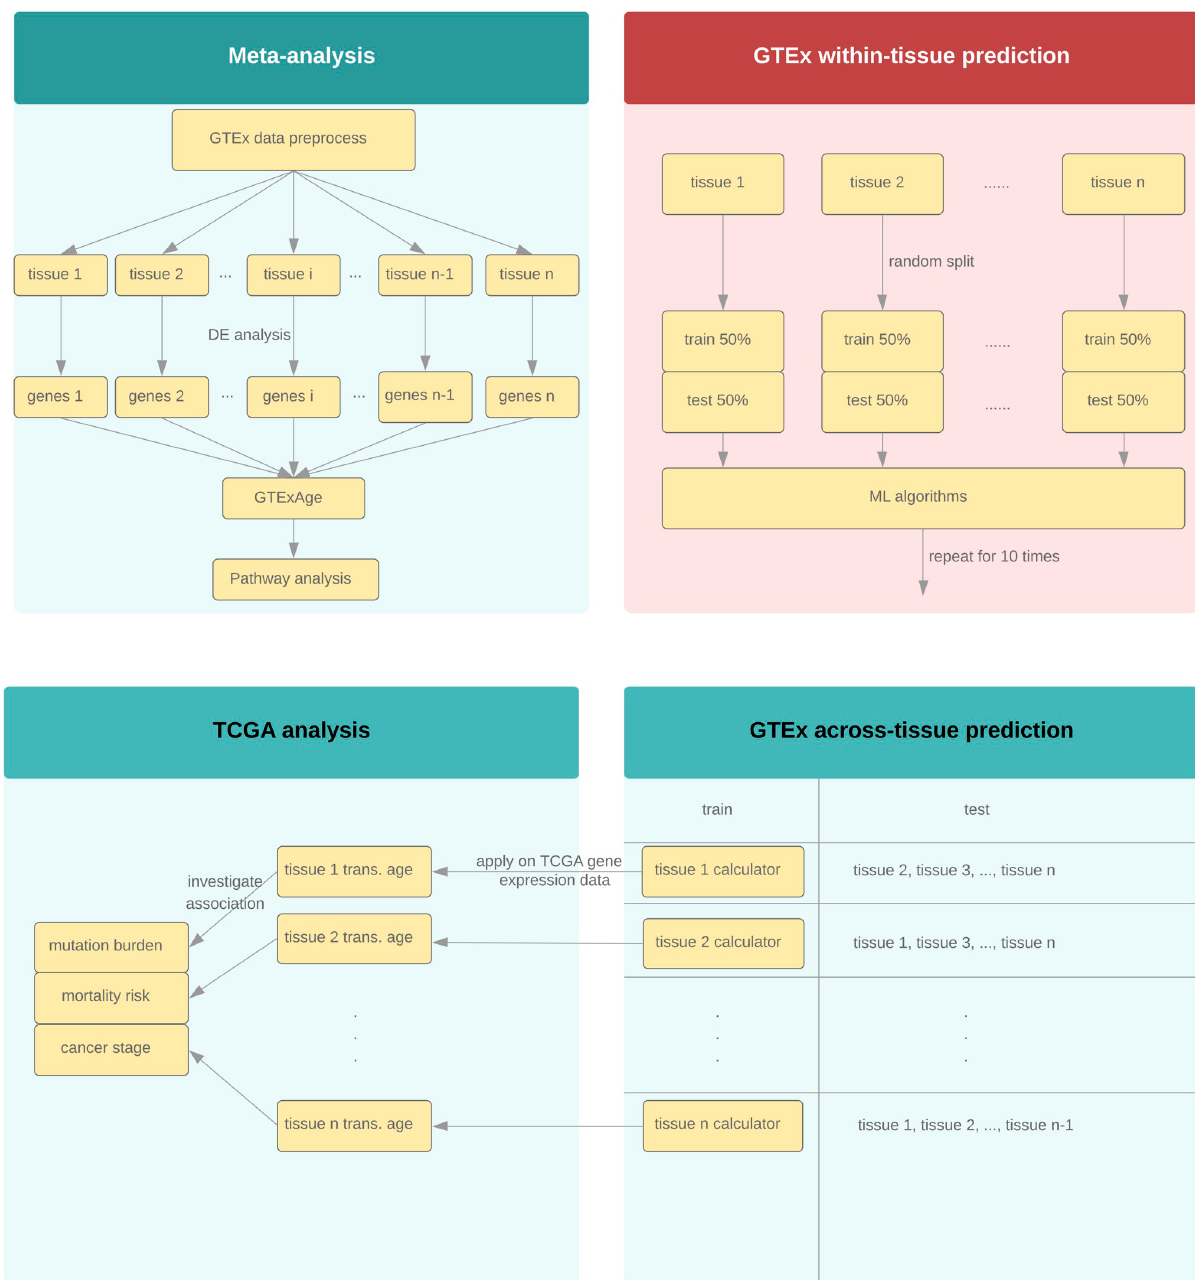
Fig 1. Overview of the transcriptional age analysis